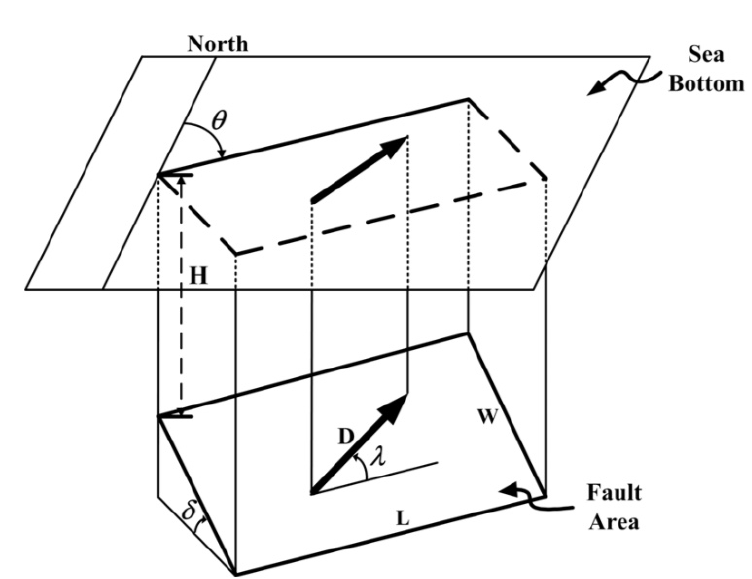
Figure 2. Definition of fault